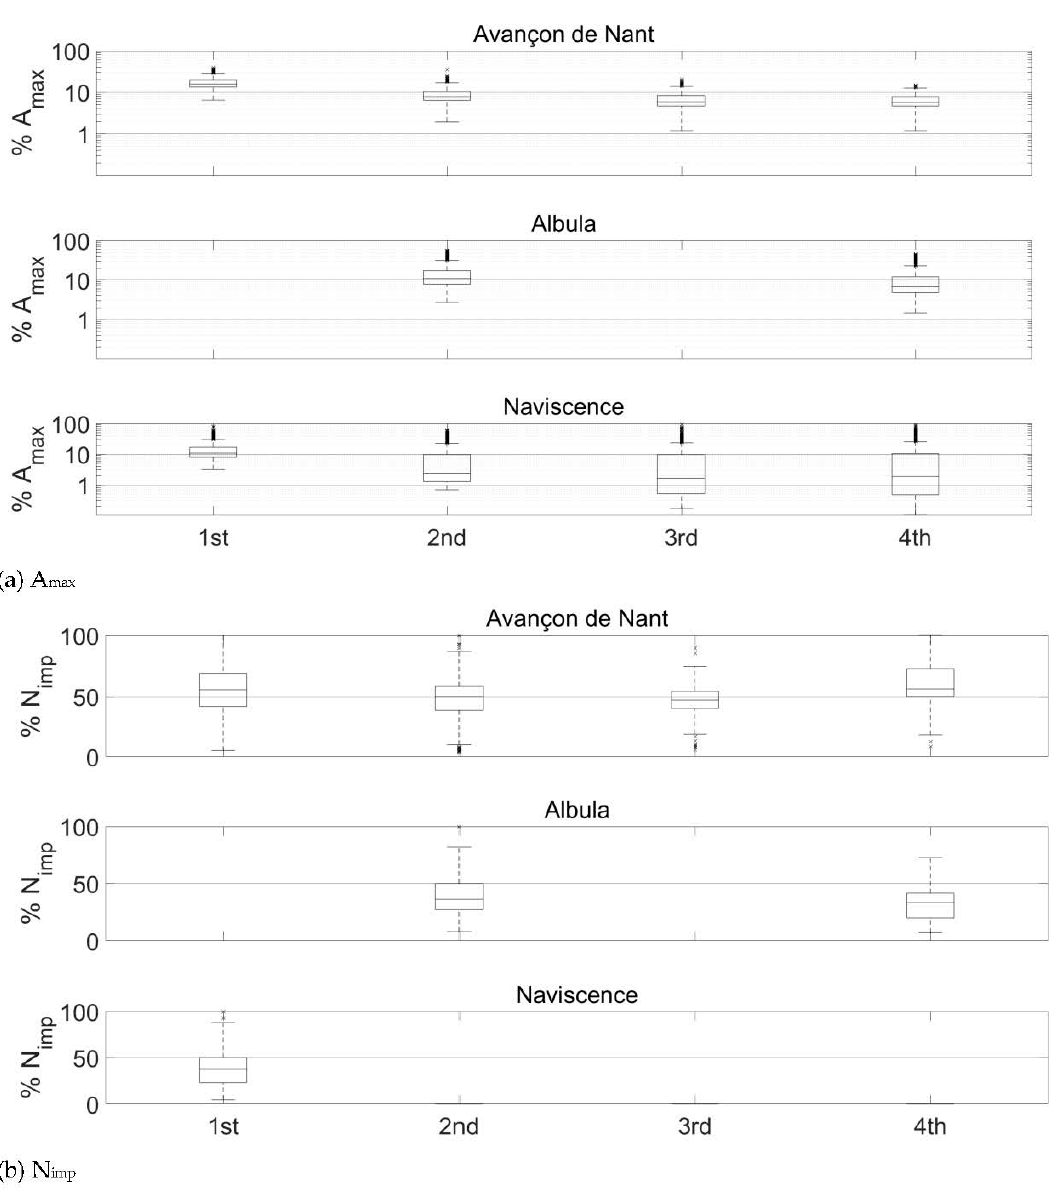
Figure 10. Percentage of ( a ) the impact A max (note the logarithmic scale on the y-axis) and ( b ) N imp ( > 0.1 V) recorded at one, two, three, and four plates of distance in all three investigated measuring stations. Boxplots show the 5th, 25th, 50th, 75th, and 95th percentiles of the distribution, outliers are marked with crosses. Note that A max covers a range of impacts between 0.01 and 10 V, while N imp (-) only considers the impacts greater than 0.1 V. At the Albula, there is no data available at one and three plates of distance, because there are accelerometers mounted below each second plate. At the Navisence, no impulses are detected further than one plate of distance.